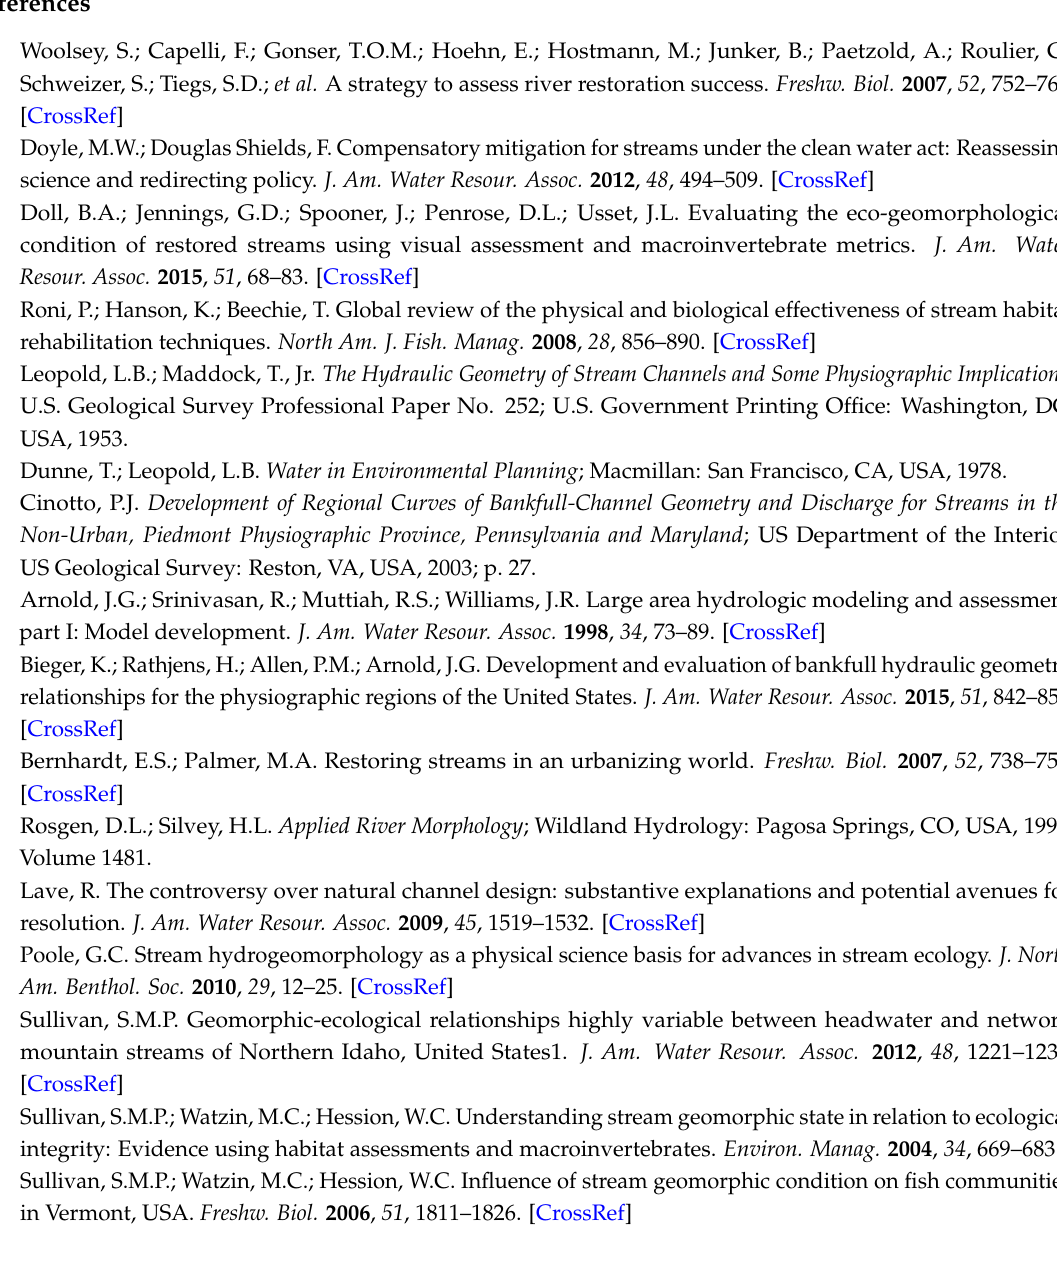
Table S1. Fish species encountered in 2011 sampling. Table S2. Significant correlative relationships between measures of fish, crayfish, and macroinvertebrate assemblages and local habitat. Table S3. Insect taxa encountered during 2011 quantitative